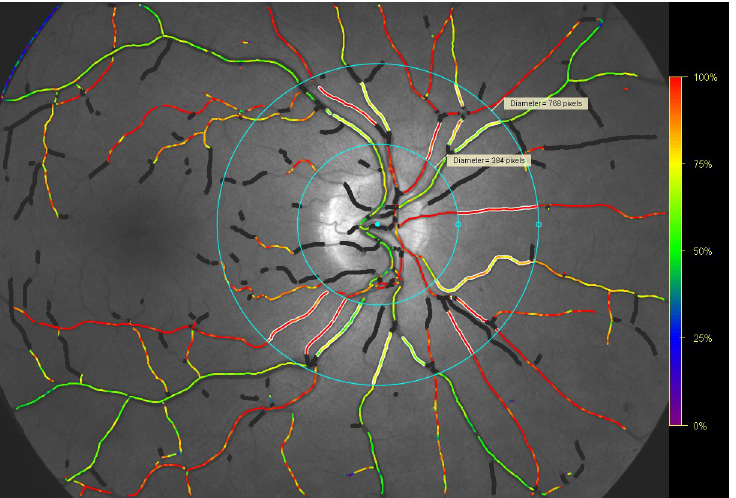
Fig 1. An oximetry image. The two blue circles demarcate the measurement area. The inner circle has a diameter of 1.5 disc diameter. The outer circle has a diameter of 3.0 disc diameters. The main retinal vessel segments in this area are chosen according to a set of detailed rules (Oxymap protocol from November 21st 2013, simple means used).